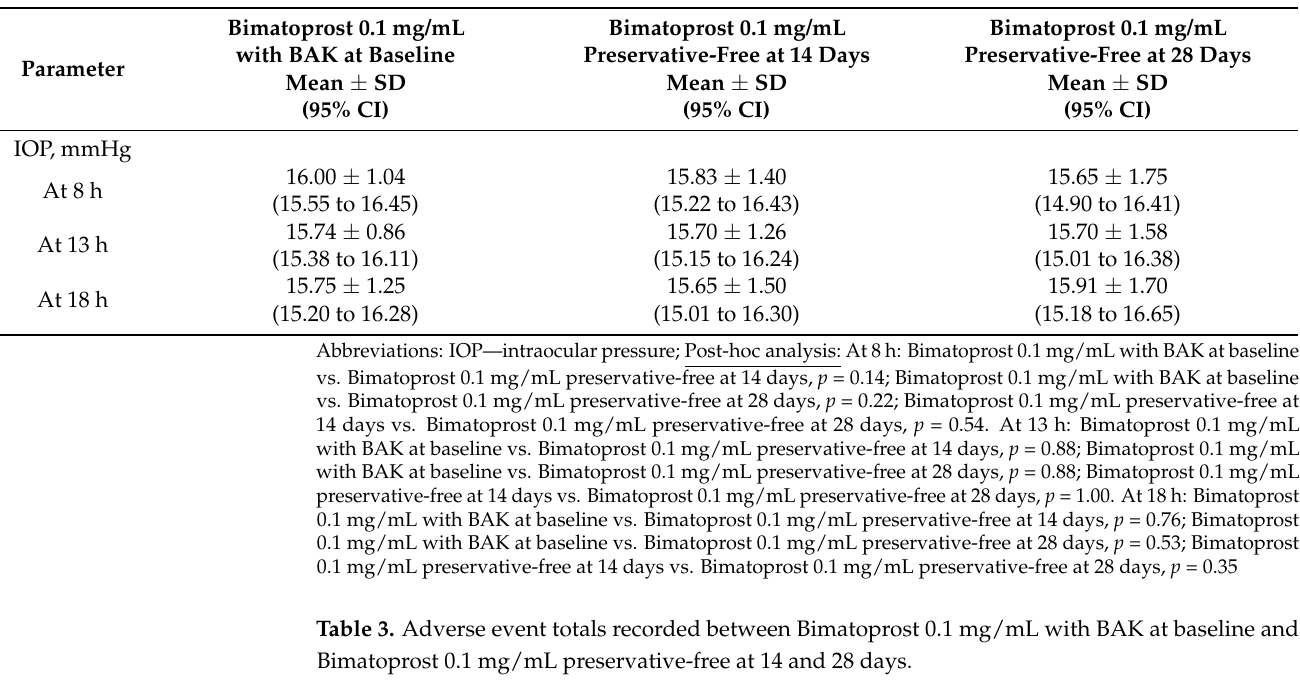
Table 2. Comparisons between the treatments and the Intraocular pressure measurements at 8, 13, and 18 h.